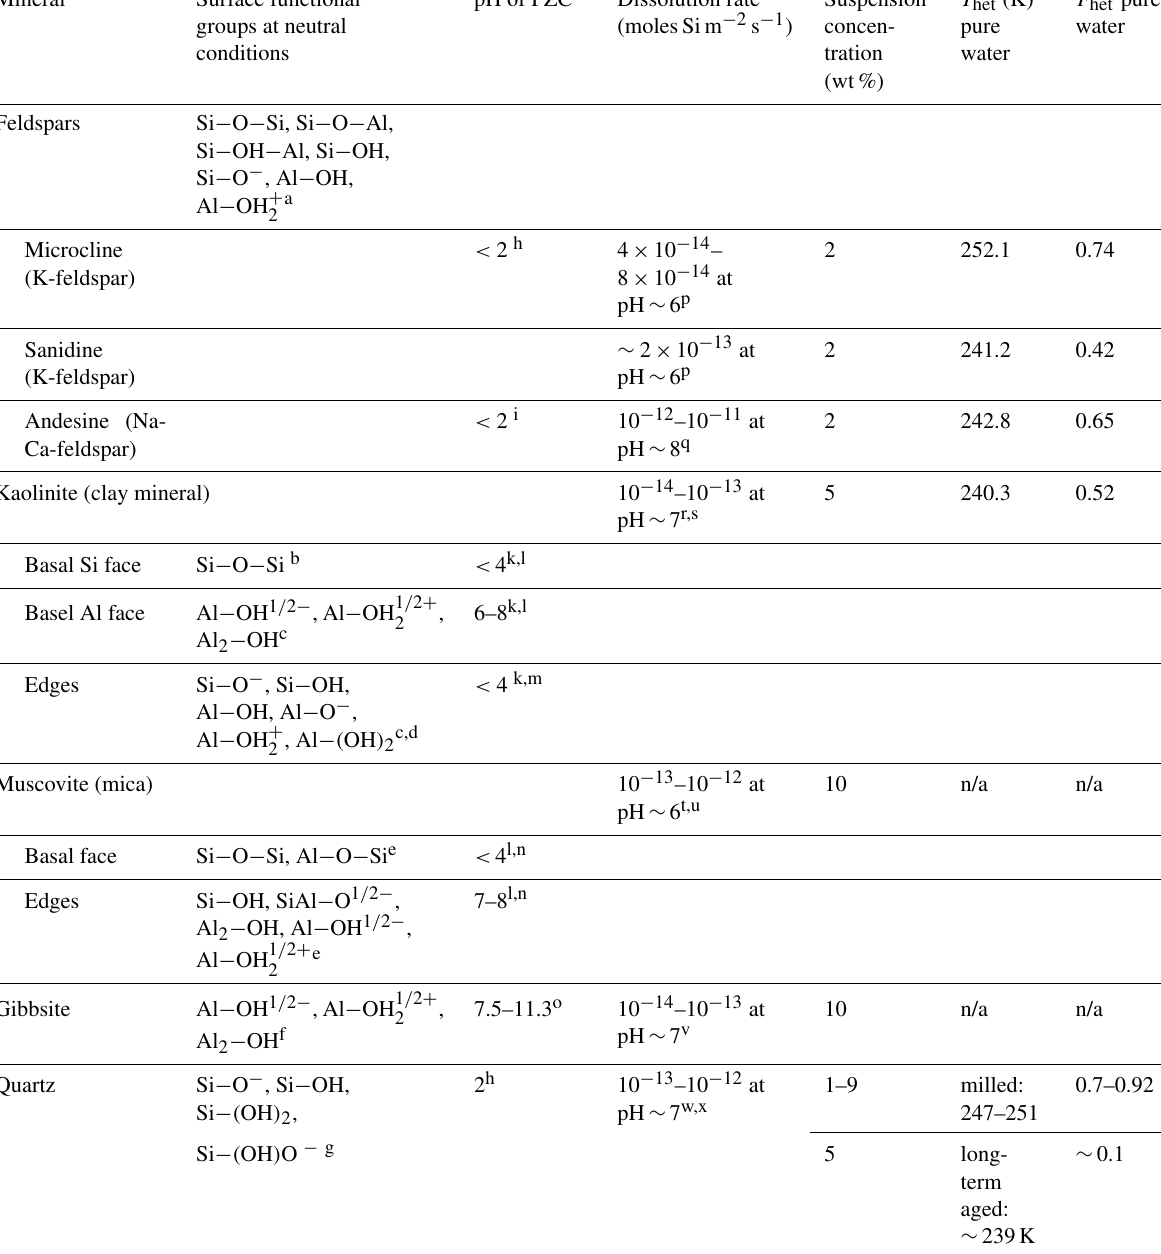
Table 3. IN activities in terms of T het and F het together with surface properties of minerals investigated in this study at near-neutral conditions (representative for pure water), microcline from Kumar et al. (2018a) and quartz from Kumar et al. (2019). pH of PZC Dissolution rate Suspension Mineral Surface functional (molesSim − 2 s − 1 ) concen- groups at neutral tration conditions